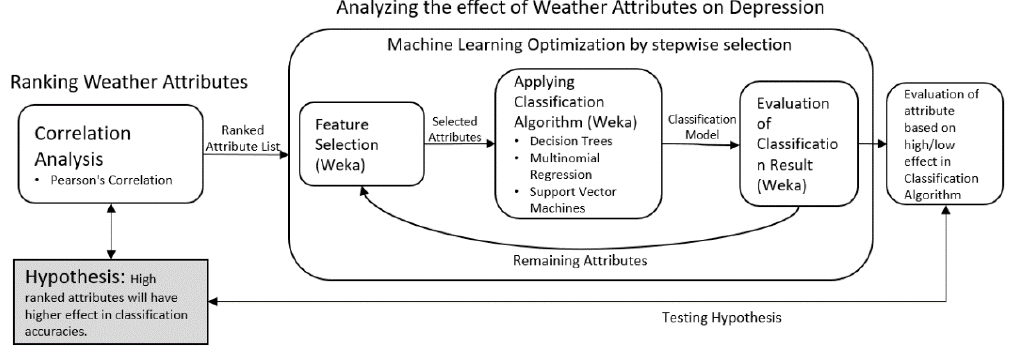
Figure 2. Methodology to identify strong predictor attributes.